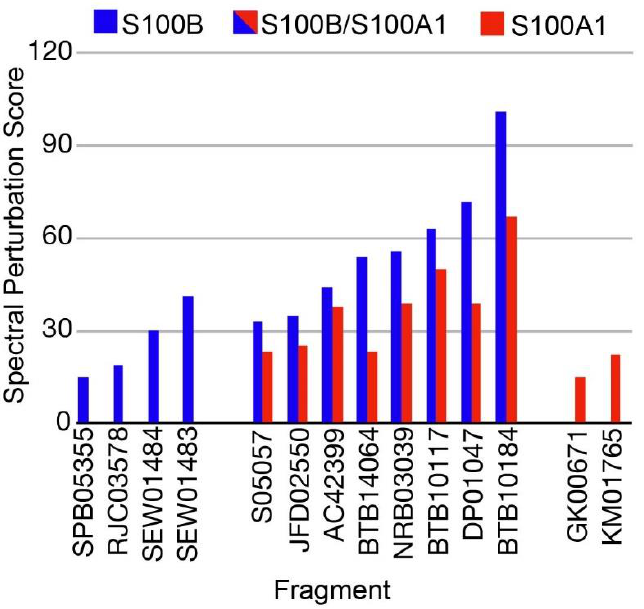
Figure 2. Maybridge Ro3 Fragments binding Ca 2+ -S100B and/or Ca 2+ -S100A1. Fragments that interact with either or both S100B (blue) and S100A1 (red). The method used to tabulate the spectral perturbations in the S100 proteins upon fragment addition is defined in Methods.